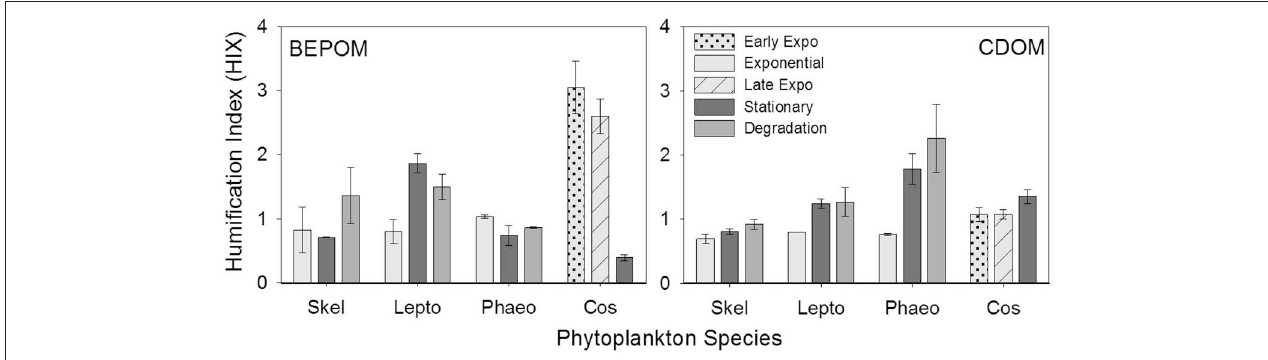
FIGURE 6 | Humification index (HIX) for BEPOM and CDOM for genera Skeletonema (Skel, n = 3), Leptocylindrus (Lepto, n = 2–4), Phaeocystis (Phaeo, n = 3), and Coscinodiscus (Cos, n = 3–4). Note the different growth stages for Coscinodiscus . All data are presented as mean ± standard error. Ratios from the initial time point were excluded due to low fluorescence at this